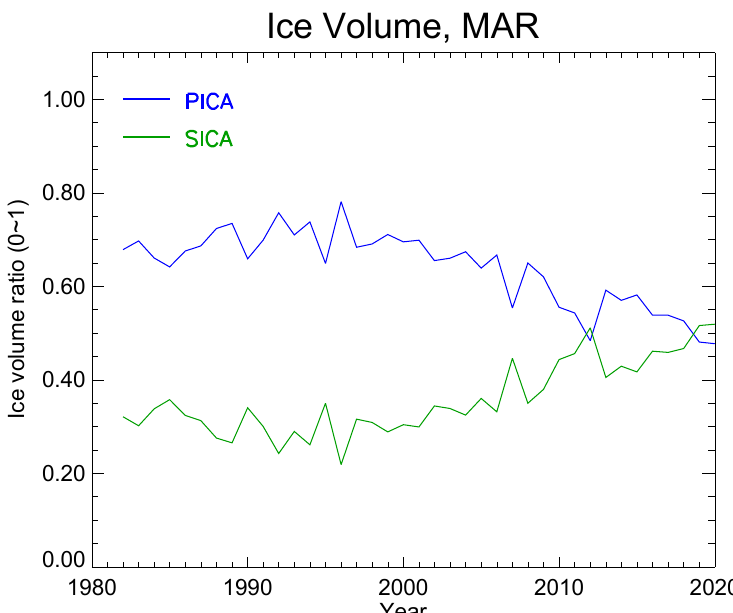
Figure 14. Ratios of PICA SIV and SICA SIV to AICA SIV in March over 1982–2020 for the Arctic area north of 60°N.